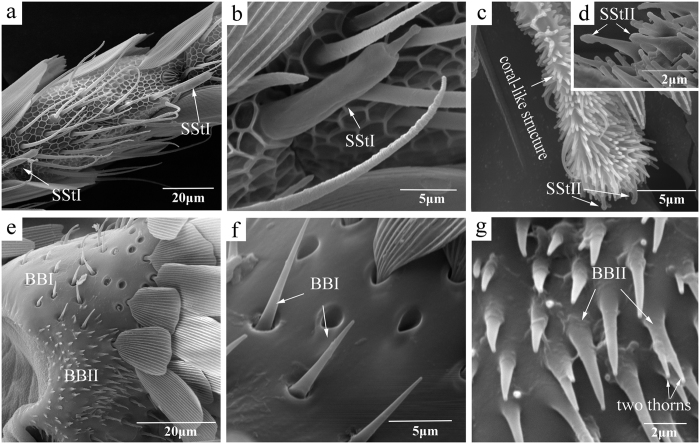
Scanning electron micrographs of sensilla styloconica (SSt) and Böhm bristles (BB) on the antennae of Sitotroga cerealella.(a–d) Shape of two types of SSt (SStI and SStII); (e–g) shape of two types of BB (BBI and BBII).